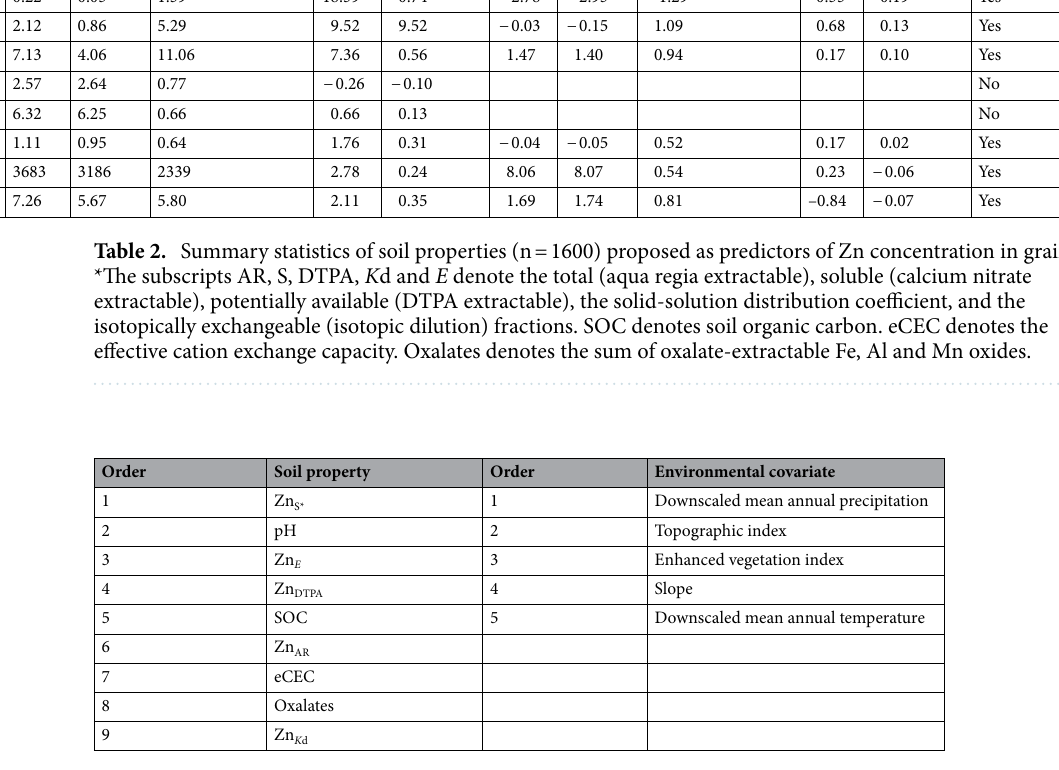
Table 3. Sequence of predictors for grain Zn concentration (both soil properties and environmental covariates) for testing with the α-investment. *The subscripts AR, S, DTPA, K d and E denote the total (aqua regia extractable), soluble (calcium nitrate extractable), potentially available (DTPA extractable), the solid- solution distribution coefficient, and the isotopically exchangeable (isotopic dilution) fractions, respectively. SOC denotes soil organic carbon. eCEC denotes effective cation exchange capacity. Oxalates denotes the sum of oxalate-extractable Fe, Al and Mn